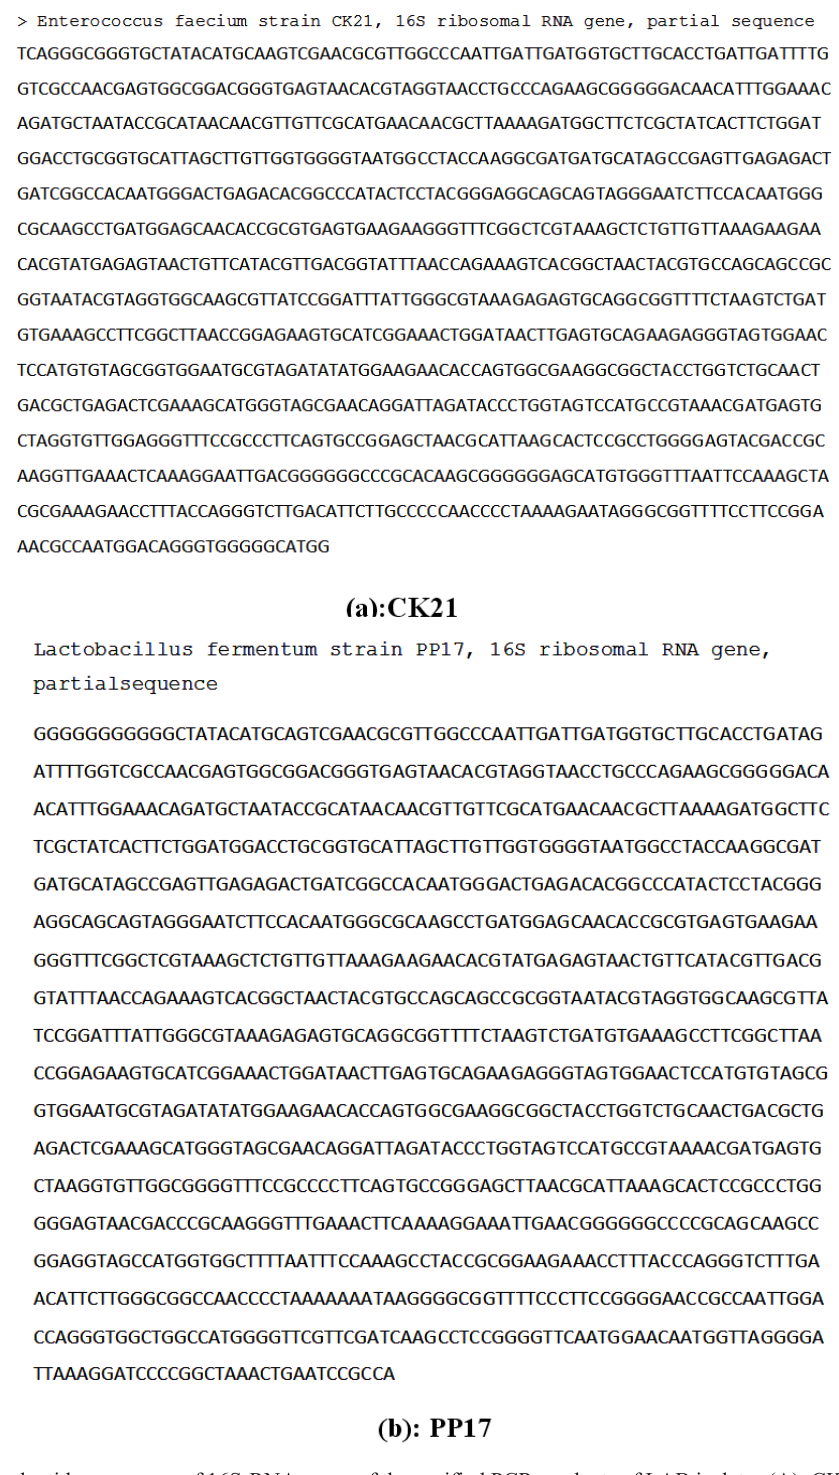
Fig. 2. Nucleotide sequences of 16SrRNA genes of the purified PCR products of LAB isolates (A); CK21 and (B);